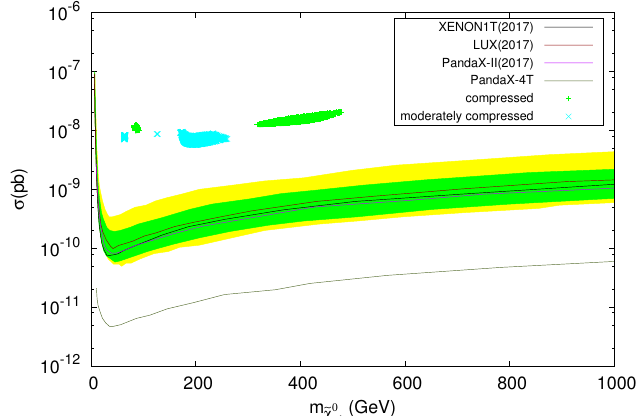
Figure 8 . Plot of spin-independent scattering cross-section (cid:27) SI for scattering of proton with as a function of the LSP mass for the compressed models ((2.4 a), (2.4 b) and (2.4 c)). Only the points which satisfy WMAP/PLANCK, a (cid:22) upto the level of 2 (cid:27) and the LHC Run II constraints are used in the calculation. The exclusion contours for XENON1T, LUX, PandaX-II and PandaX-4T experiments are shown as black, red, magenta and green lines respectively. In green and yellow are shown 1 (cid:27) and 2 (cid:27) sensitivity bands respectively of the XENON1T data.